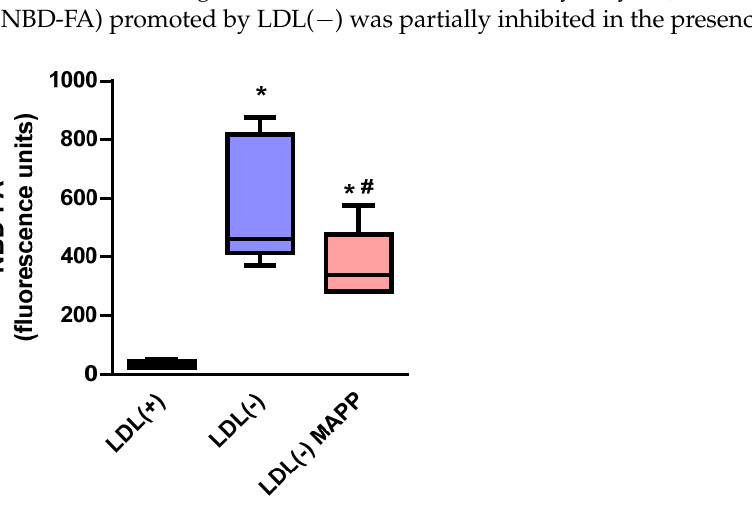
Figure 4. Degradation of NBD-labeled Cer by LDL( − ). NBD-Cer was incubated with LDL(+), LDL( − ), and LDL( − )+MAPP for 24 h at 37 °C. Degradation of NBD-Cer was measured as the formation of NBD-FA ( n = 7). * p < 0.05 versus LDL(+); # p < 0.05 versus LDL( − ) alone.